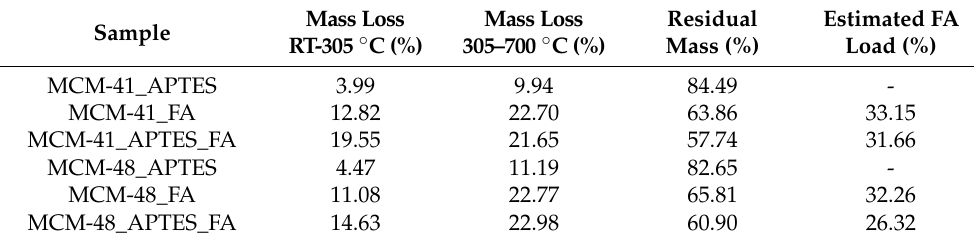
Table 4. Most important data from thermogravimetric